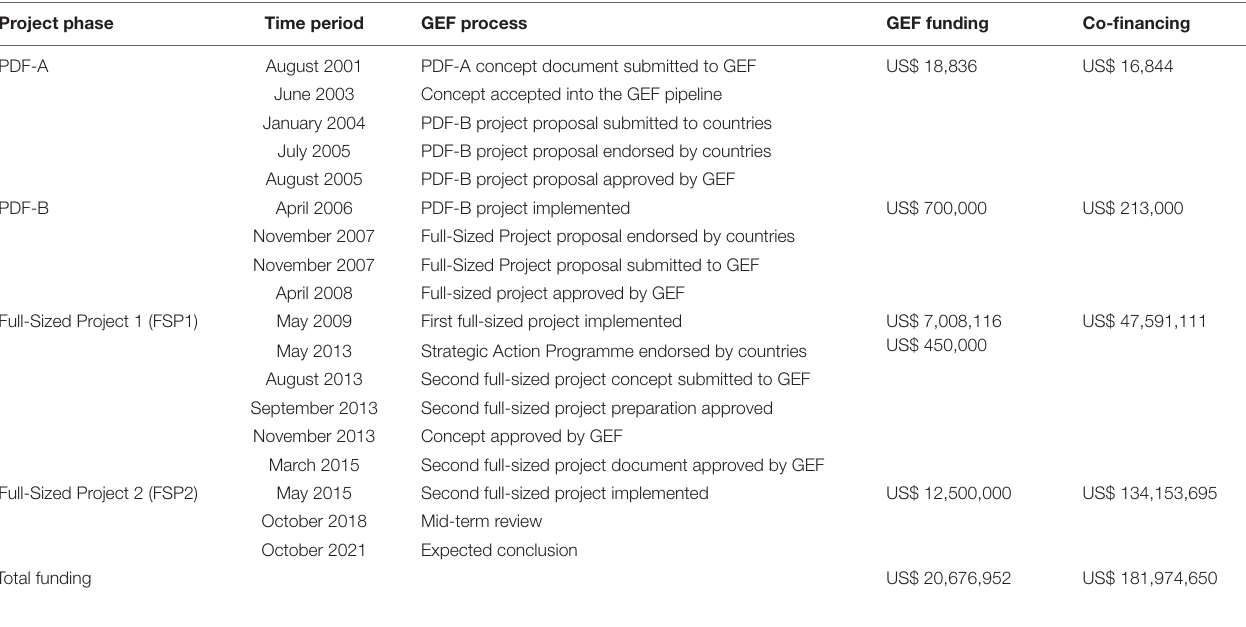
TABLE 1 | GEF-IW program submission and funding